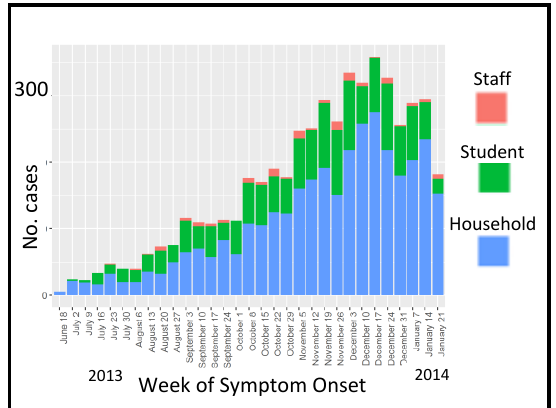
Figure 10 . 75 Combined Totals from 75 iterations organized by